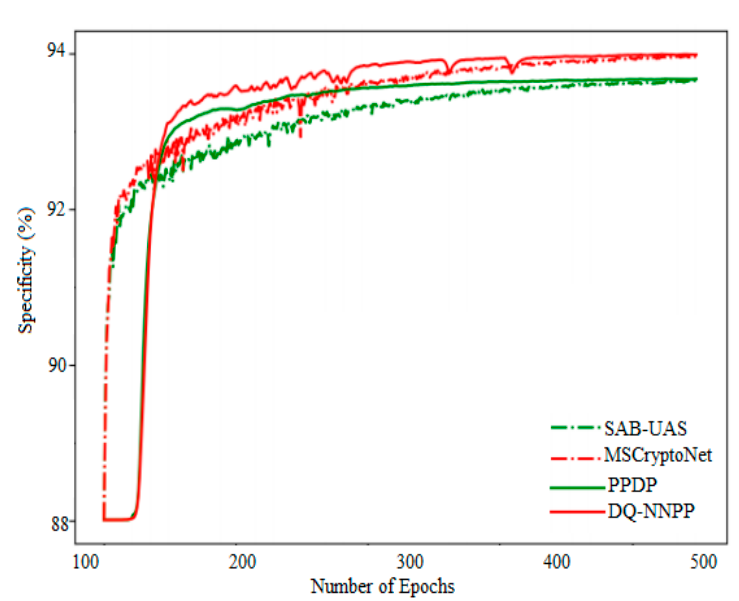
Figure 6. Comparison of specificity.